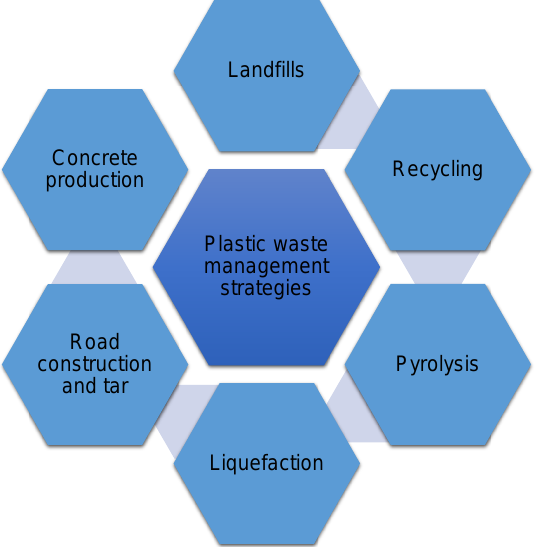
Figure 11. Various management techniques for plastic